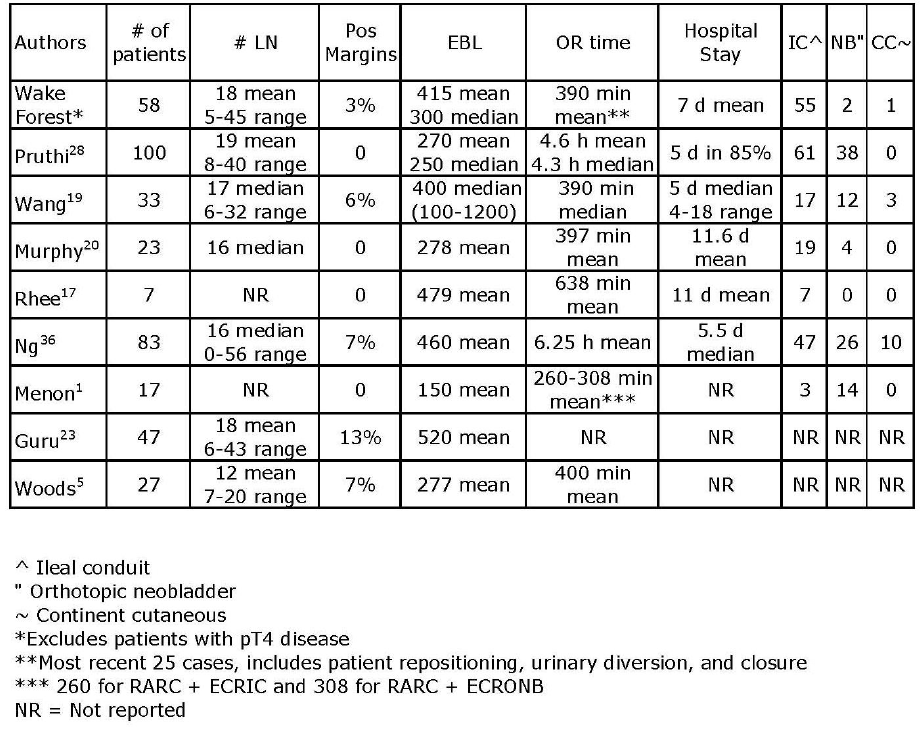
Comparison of RARC